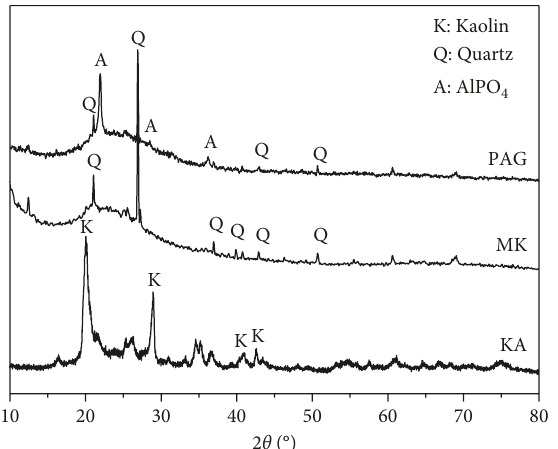
Figure 11: X-ray diffraction patterns of kaolin (KA) [12], calcined kaolin (MK) [12], and phosphate acid-based geopolymer (PAG).